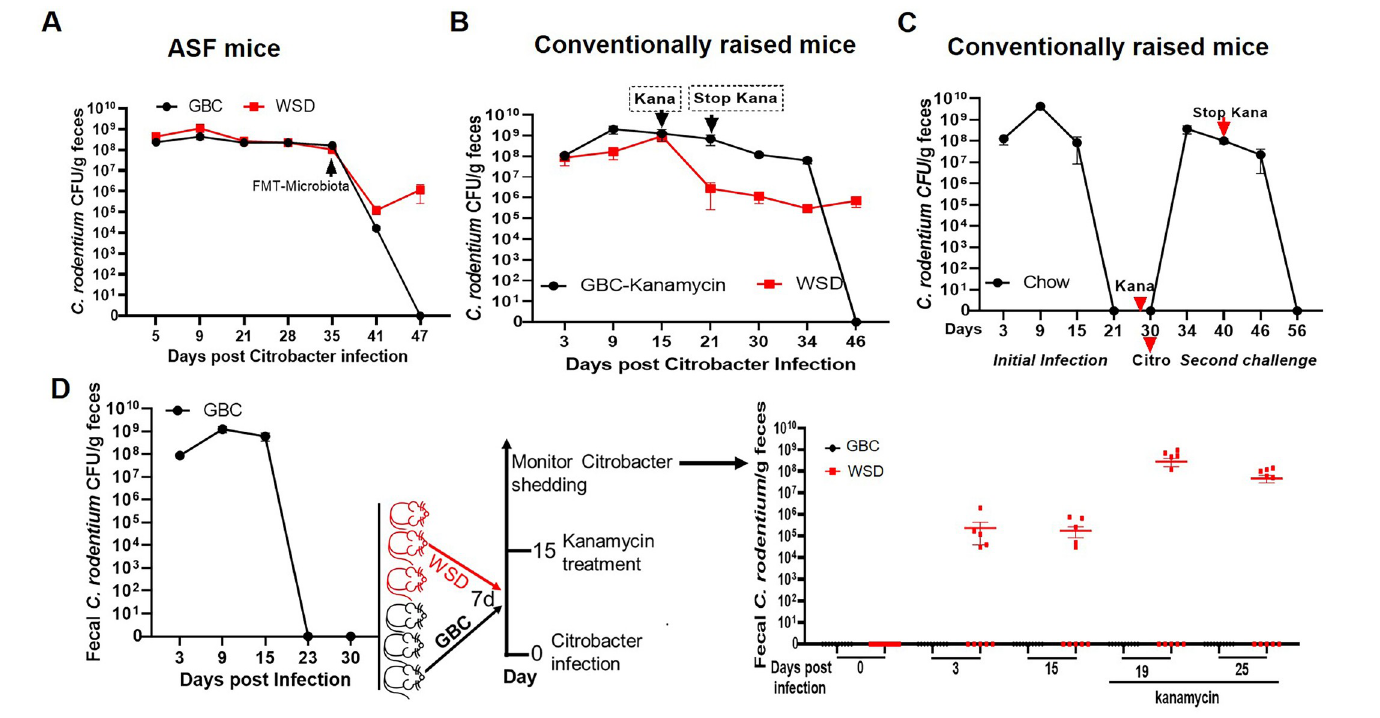
Fig 6. A complex microbiota nourished by GBC mediates clearance of C . rodentium persistent infection. A . ASF mice fed GBC or WSD were orally inoculated with C . rodentium and 35d later, administered feces from conventional GBC-fed mice. B. Conventional GBC-fed mice were orally inoculated with C . rodentium . 15 days later, mice were left untreated or orally administered kanamycin (1000mg/kg) on days 15, 17, 19, and 21. C . GBC-fed, C . rodentium infected mice were administered kanamycin at day 29 post-inoculation, and re-administered C . rodentium at day 30, kanamycin was administered every other day until day 40. D . GBC-fed mice were administered C . rodentium , which they uniformly cleared by 30d, at which time they were maintained on GBC or switched to WSD. One week later, mice were re-challenged with C . rodentium and treated with kanamycin 15 d later. All data are fecal C. rodentium CFU on indicated day in that experiment. Data are the means +/- SEM (n = 3–10 mice per